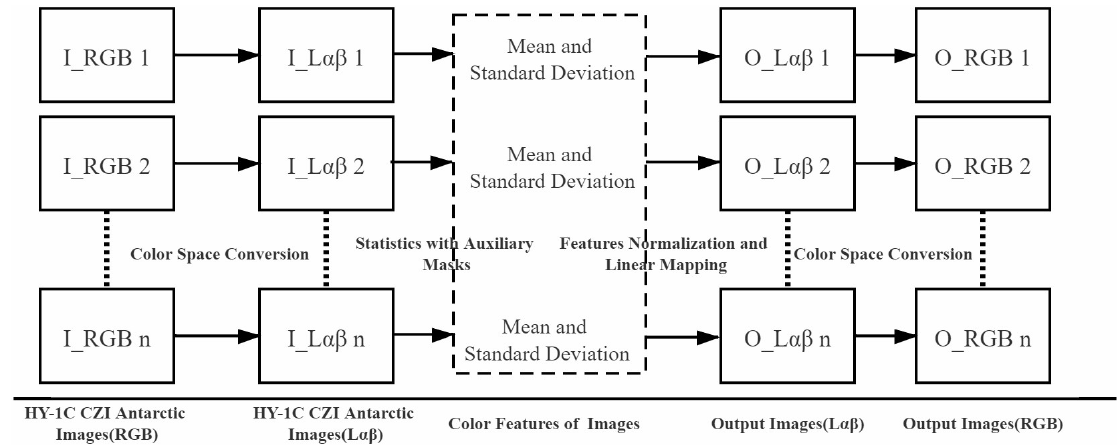
Figure 8. The flowchart of multi-view color consistency